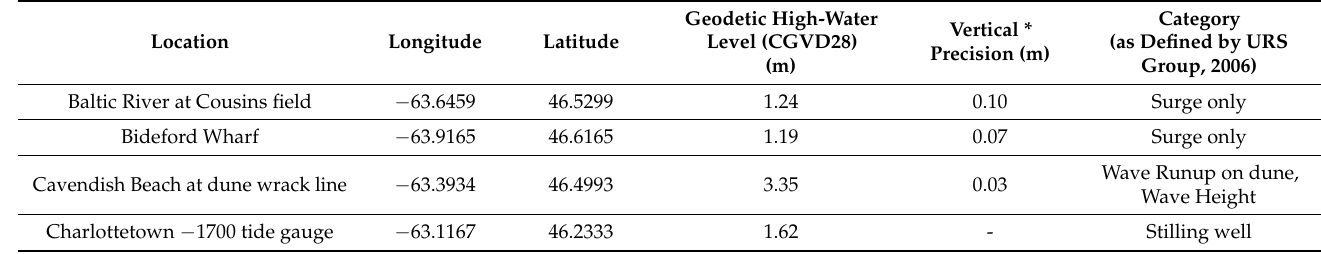
Table A1. Measured HWMs along PEI Coast after